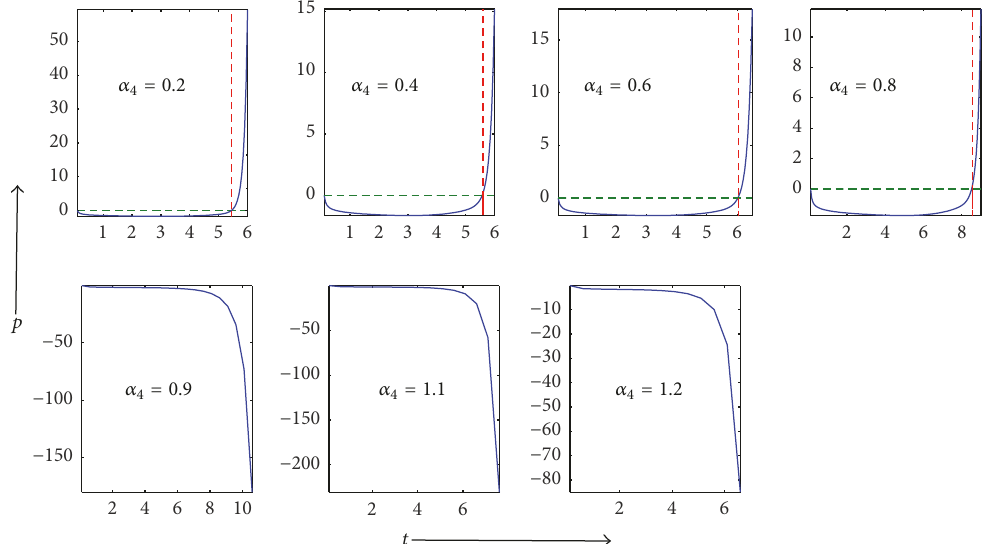
Figure 6: Variation of pressure against time for 𝛼 1 = 0.5 , 𝛼 2 = 0.5 , 𝐴 = 𝐵 = 1 , 𝑛 = 0.1 , 𝜔 = 1 , 𝜙 0 = 1 , 𝑐 2 = 0.1 , and different 𝛼 4 .